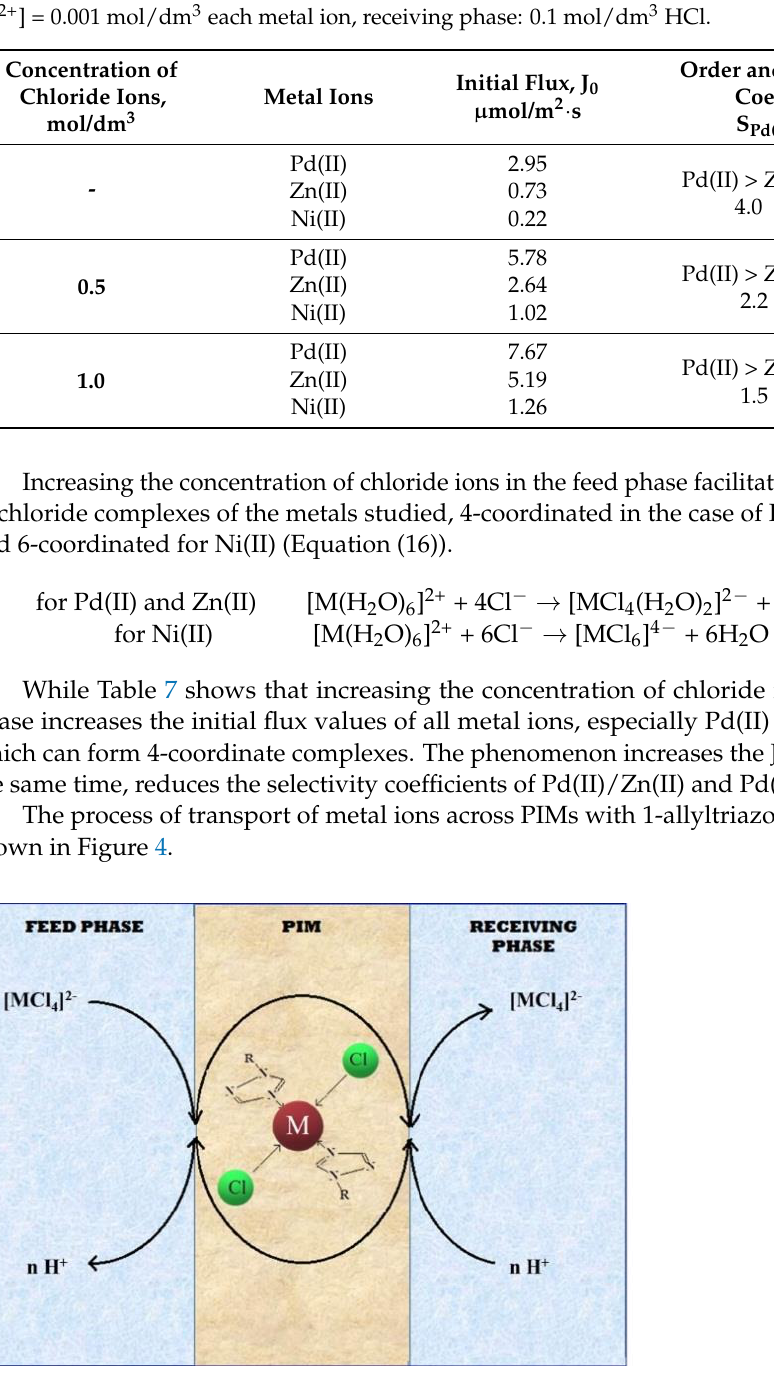
Table 7. Influence of chloride ion concentration in the feed phase on kinetic parameters, order and Pd(II) ion separation coefficient in transport across PIMs with 1-pentyl-1,2,4-triazole ( 1 ). Mem-